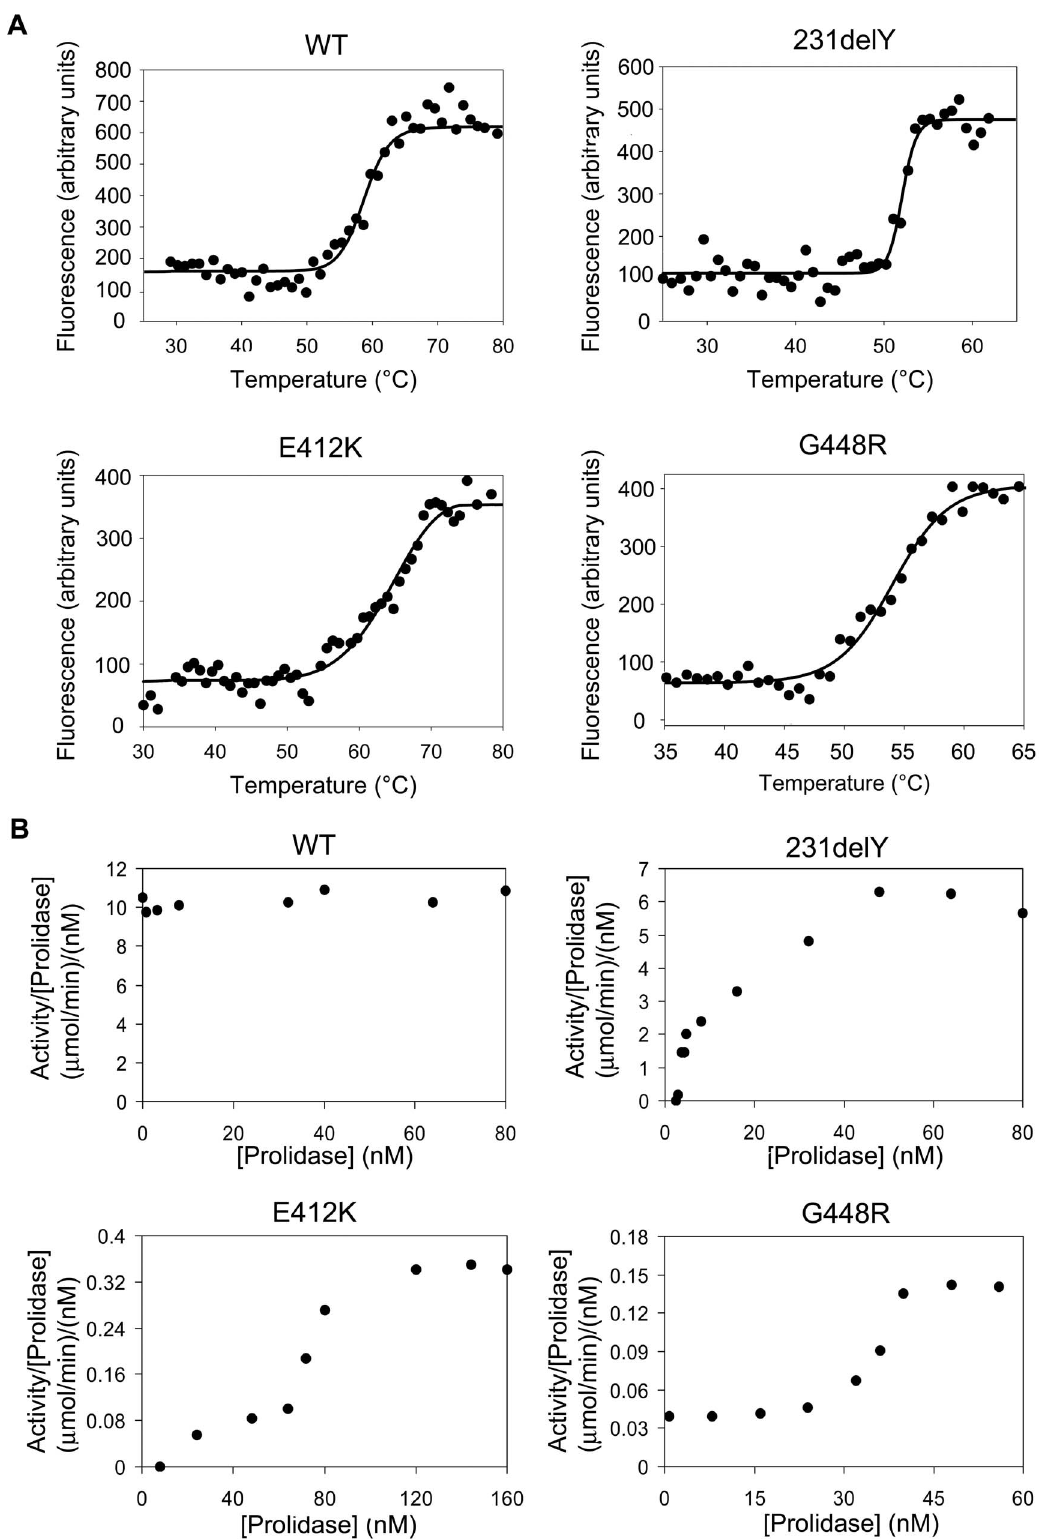
Figure 3. Prolidase thermal denaturation and dimerization follow up. (A) Protein melting temperatures in the presence of the cofactor as revealed by Thermofluor Technology. The solvatochromic dye SYPRO orange was used as an indicator of protein unfolding (fluorescence excitation l =492 nm; fluorescence emission l =568 nm). (B) The ratio between prolidase activity and protein concentration was plotted against protein concentration.